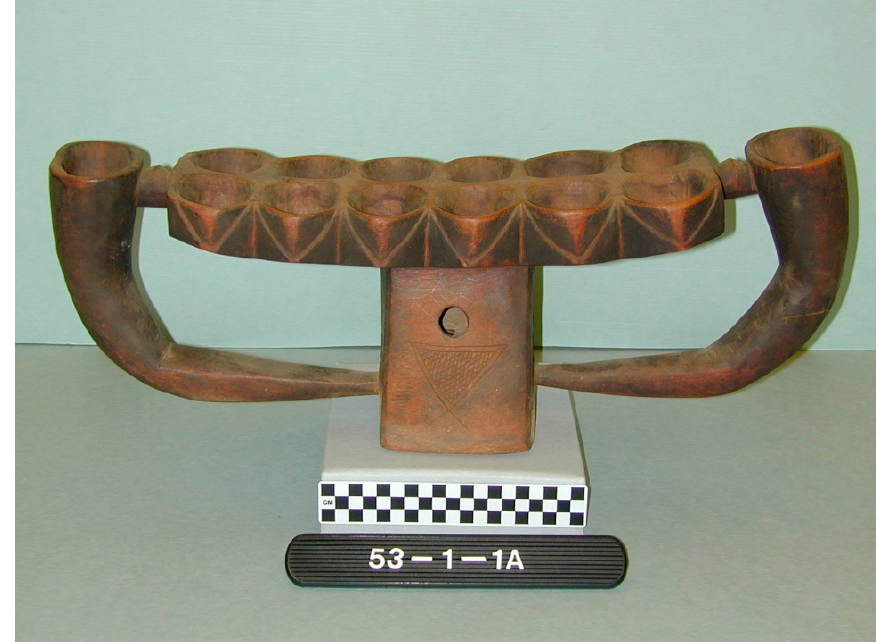
Figure 1. Historical Mancala game board with two rows of six pits and a store usable for the Kalah game [30].